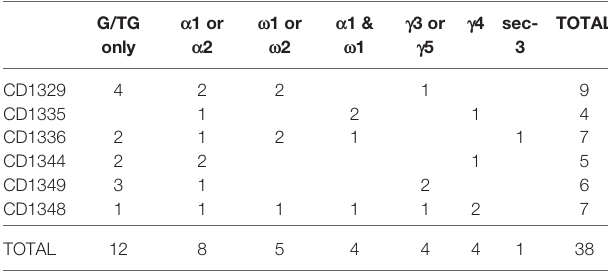
TABLE 3 | Summary of epitope speci fi cities of gluten-reactive TCC. G/TG only